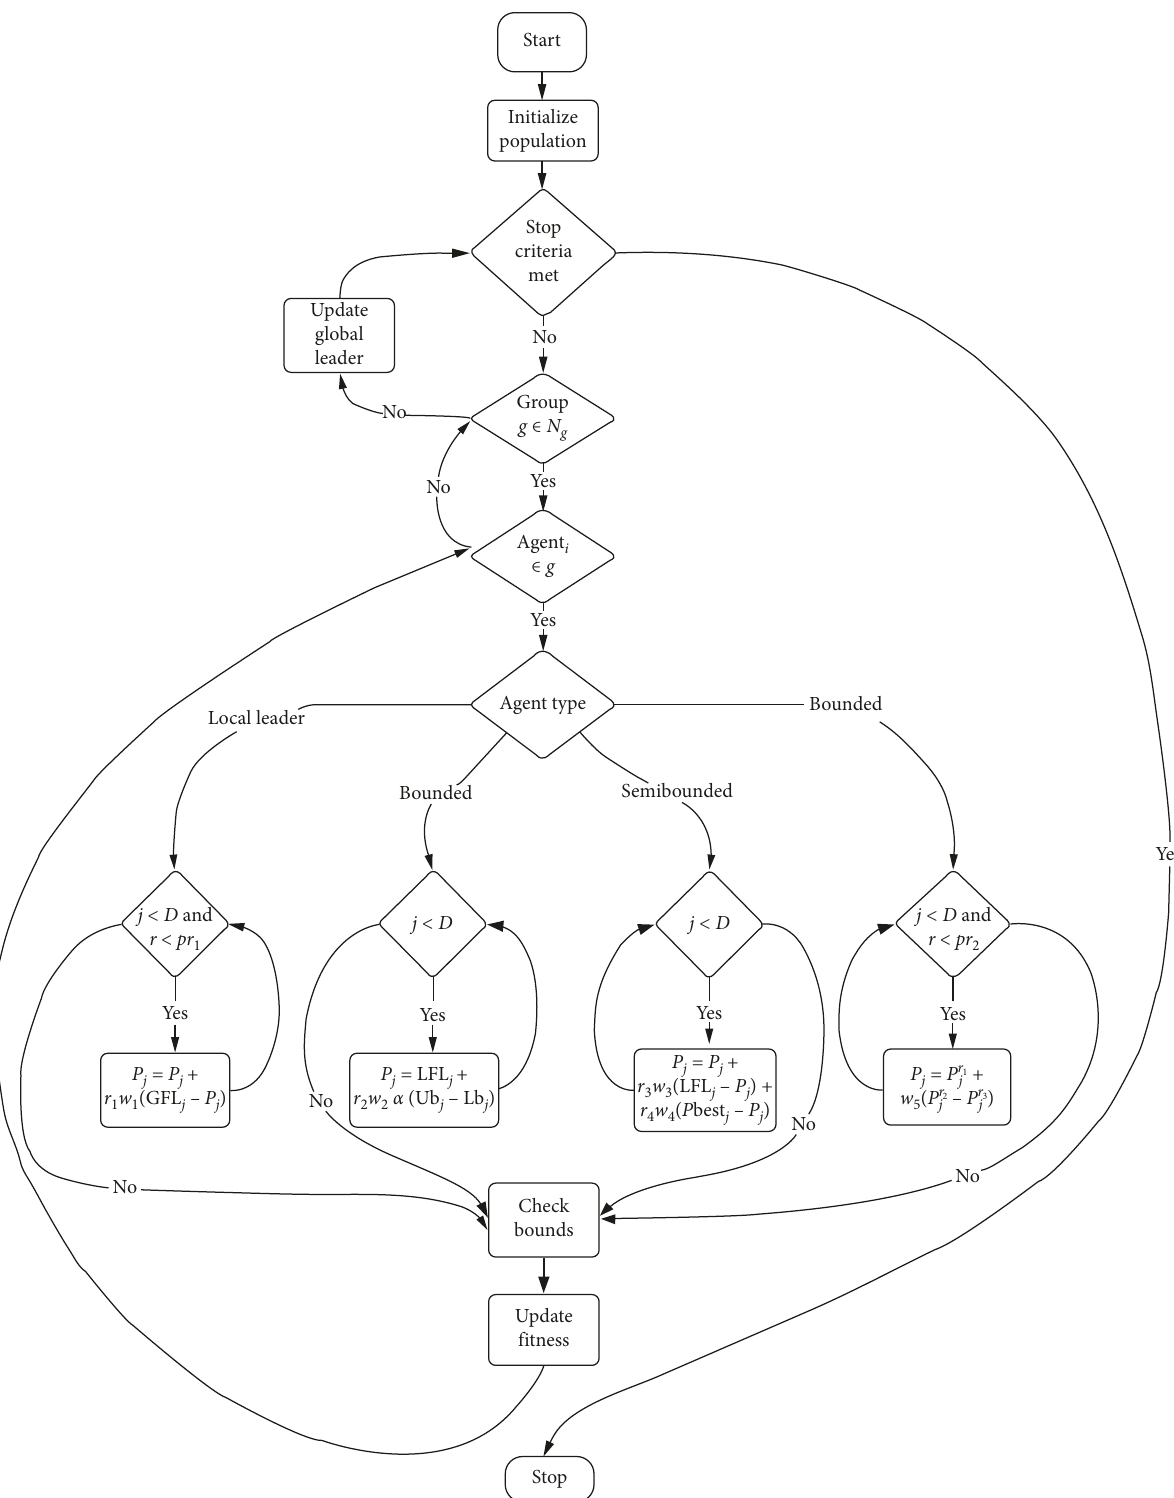
Figure 3: Flowchart of the SCEO